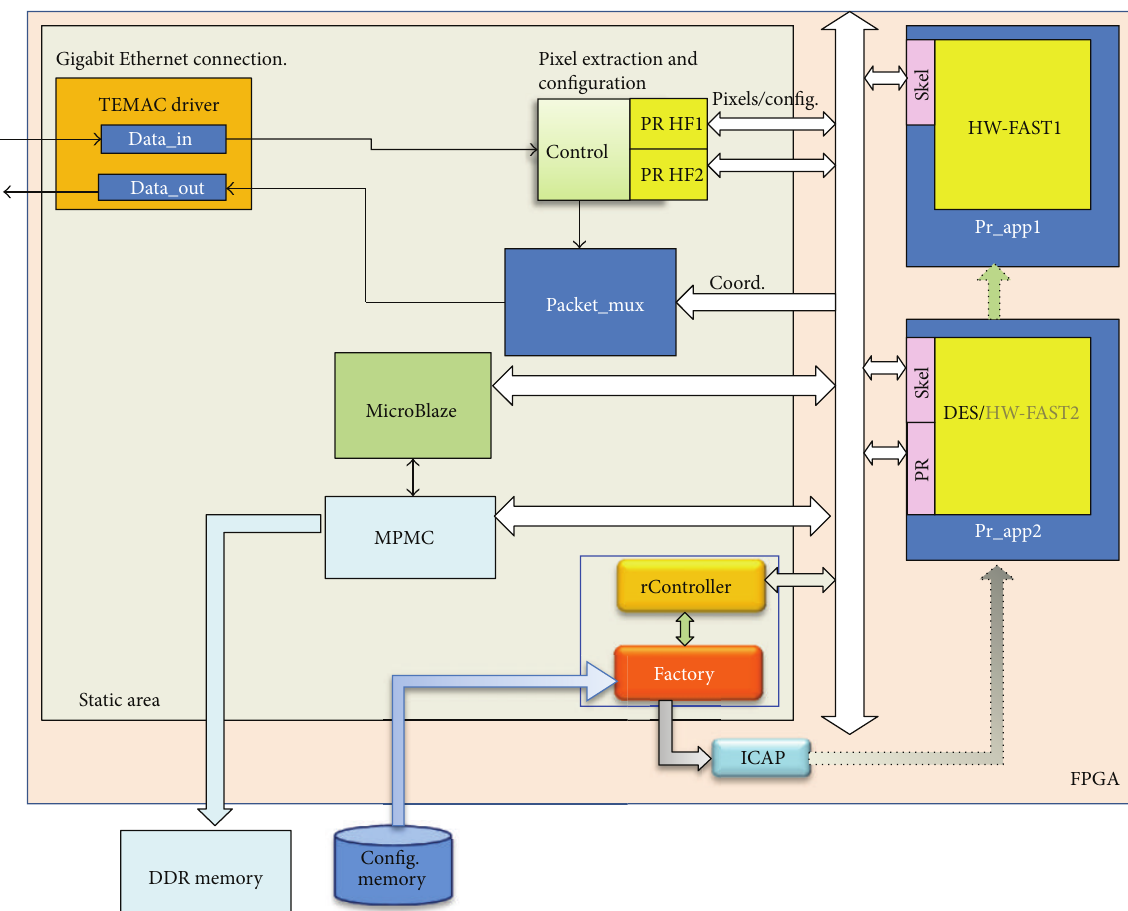
Figure 10: Block diagram of HW-FAST